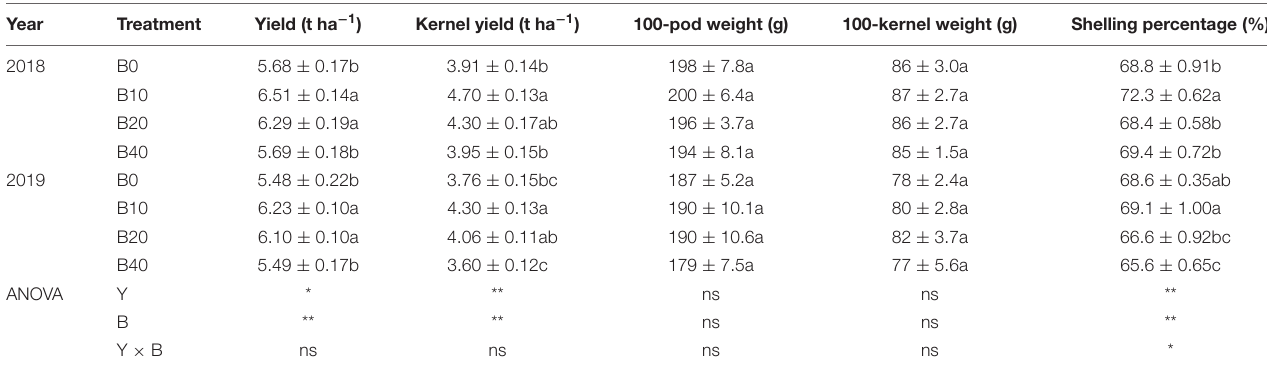
ANOVA Y B ** ** Y × B ns ns ns ns ns Y and B represent year and biochar application, respectively. B0, B10, B20, and B40 represent biochar application rates at 0, 10, 20, and 40 t ha − 1 , respectively. For each parameter in each year, mean data with different letters denote significant difference among treatments at P < 0.05. ∗∗ and ∗ denote significance at the 0.01 and 0.05 probability levels, respectively. ns denotes non-significance. TABLE 4 | Yield and yield components of peanut applied with four rates of biochar in the 2018 and 2019 growing seasons. Year Treatment